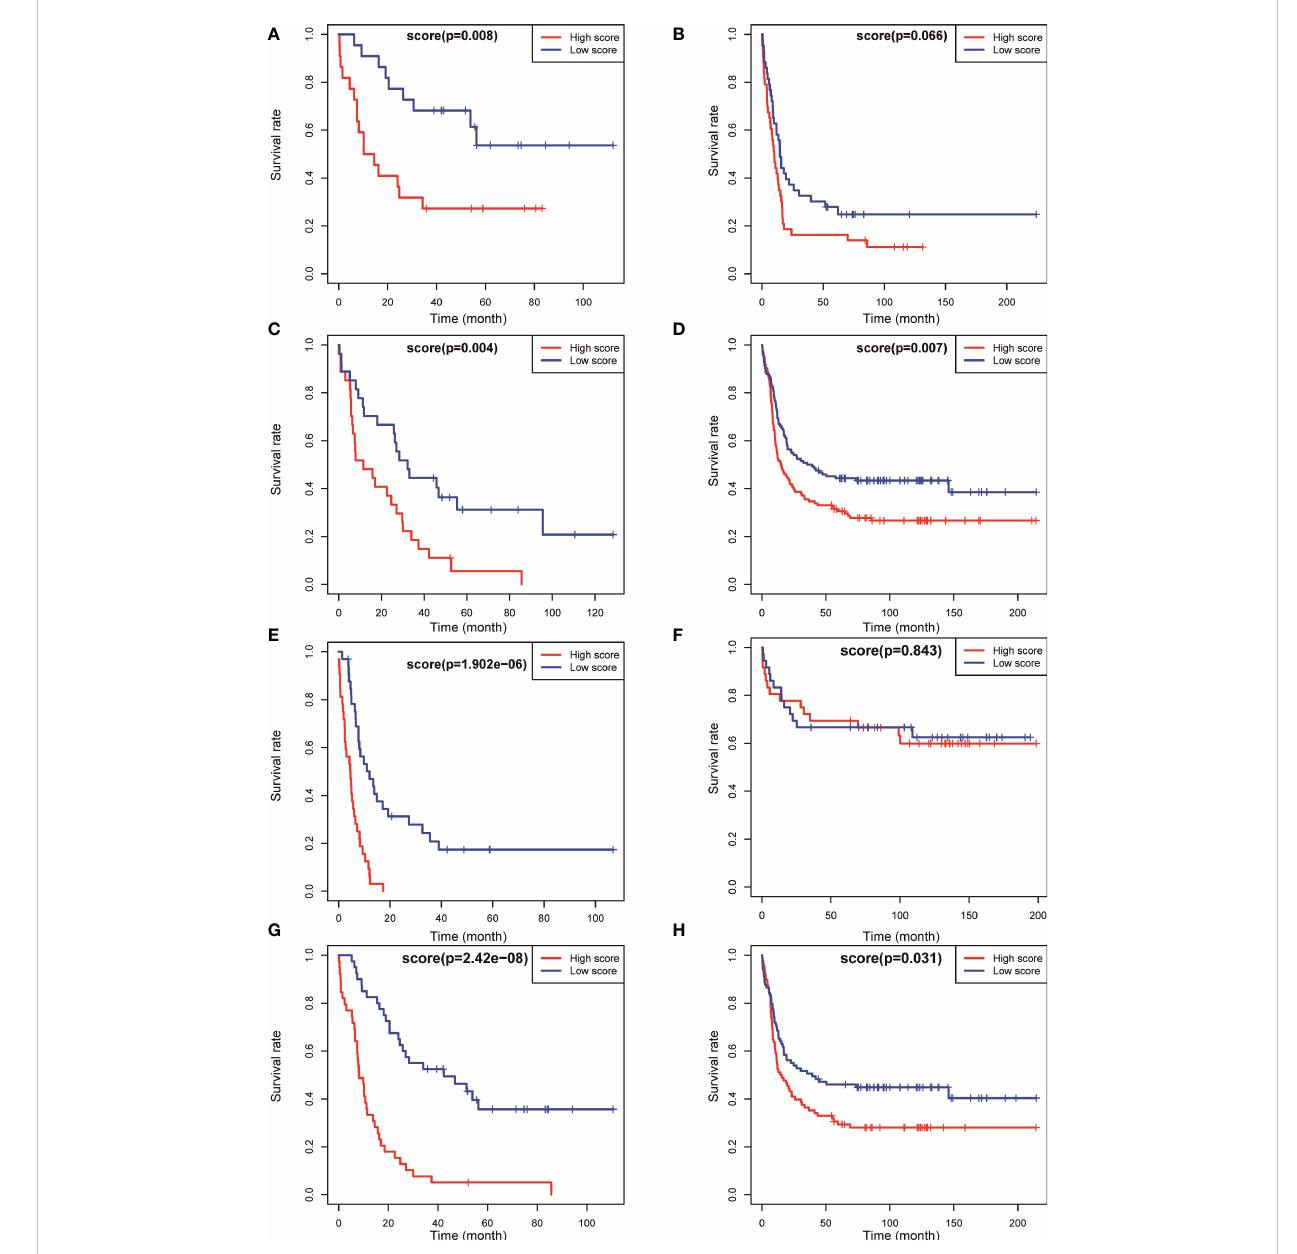
FIGURE 4 Kaplan – Meier survival analysis of OS for patients in different NCCN risk strata was performed based on high and low risk scores. OS of the favorable- risk subgroup in TCGA (A) and GSE6891 (B) ; OS of the intermediate-risk subgroup in TCGA (C) and GSE6891 (D) ; OS of the poor-risk subgroup in TCGA (E) and GSE6891 (F) ; and OS of the normal-karyotype subgroup in TCGA (G) and GSE6891 (H)